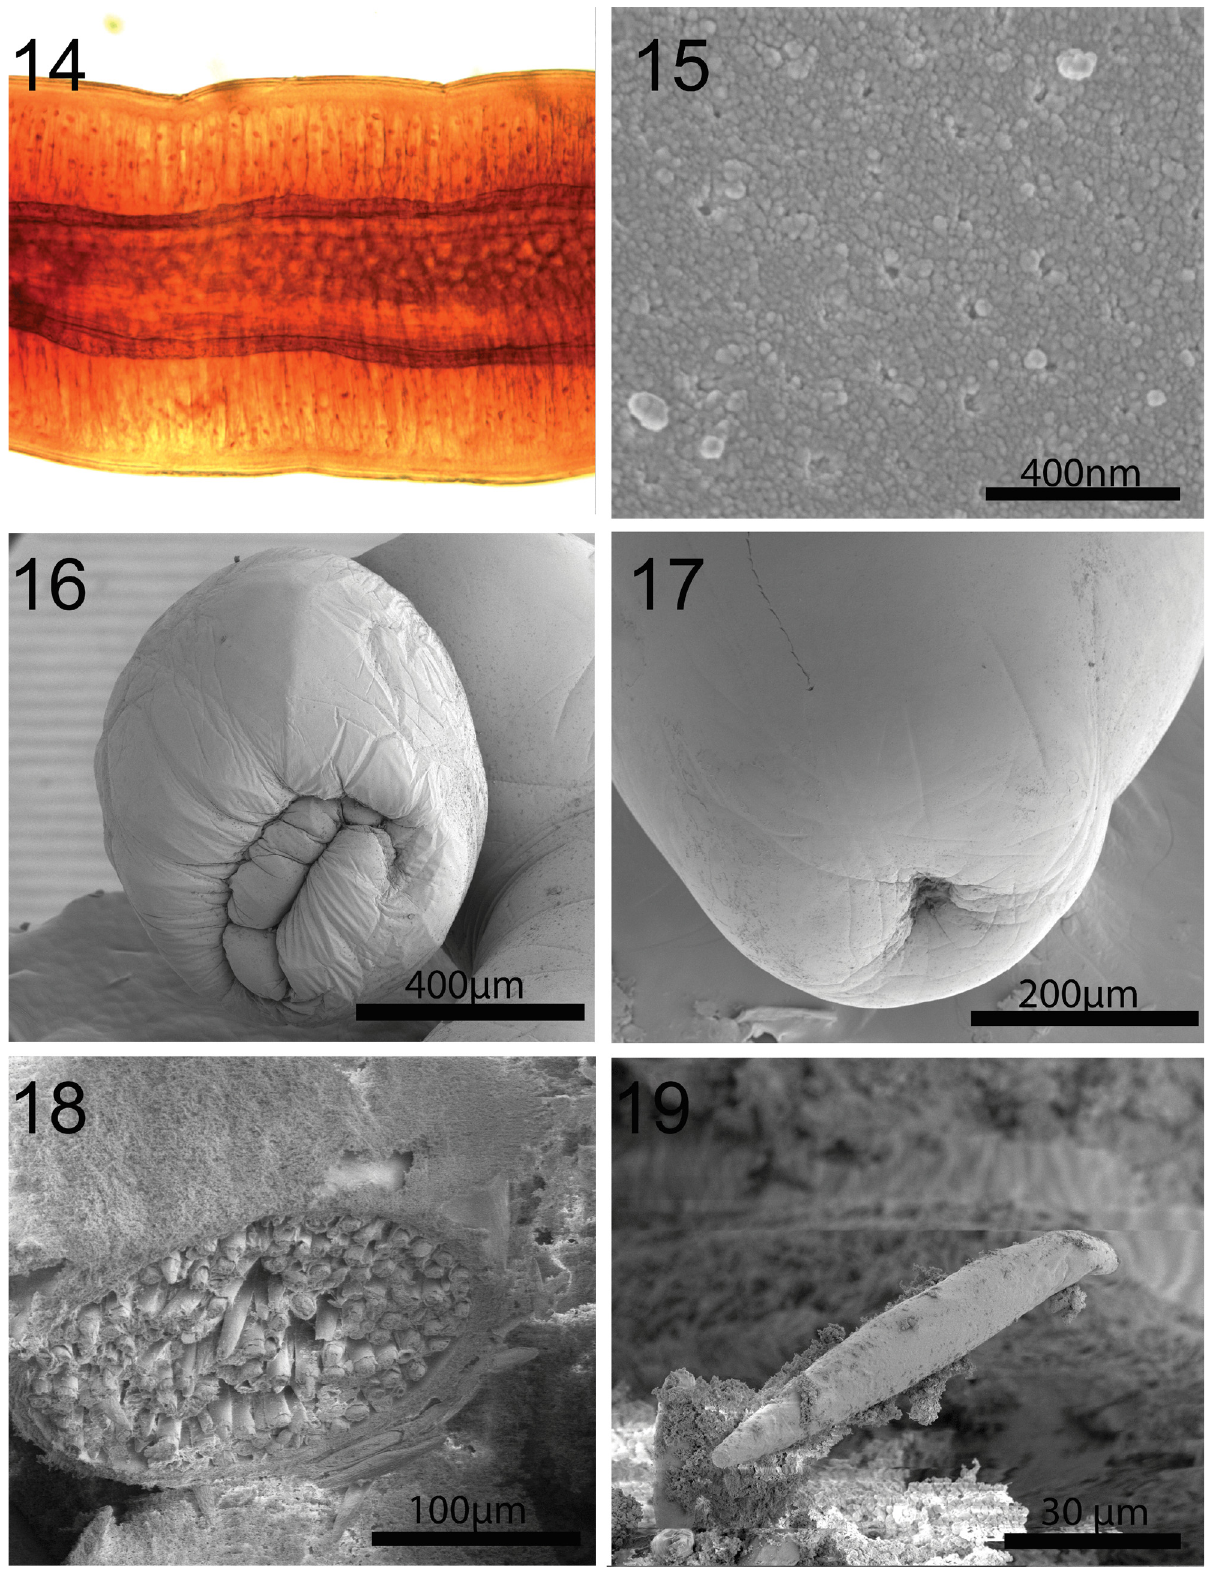
Figures 14-19. SEM and microscopic images of specimens of Cavisoma magnum collected from Mugil cephalus in the Arabian Gulf. 14. A microscopic image of a section of a female specimen showing the outer cuticle, thick tegument and the darker internal circular muscle layer. 15. Epidermal micropores in the posterior trunk section of a worm. 16. A basal perspective of a bursa showing its thick unornamented muscular organization with invagination of its inner ori fi ce. 17. A ventro-lateral view of the terminal female gonopore. 18. A high magni fi cation of packed eggs in the ligament sac of a gravid female. 19. A fully developed ripe